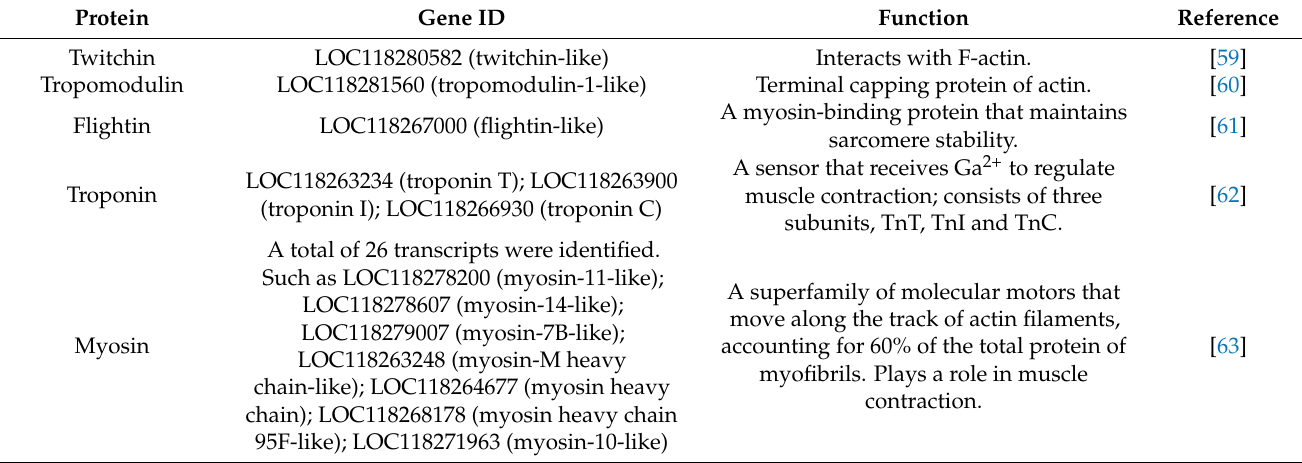
Table 2. Flight muscle structural protein-encoding genes of S. frugiperda